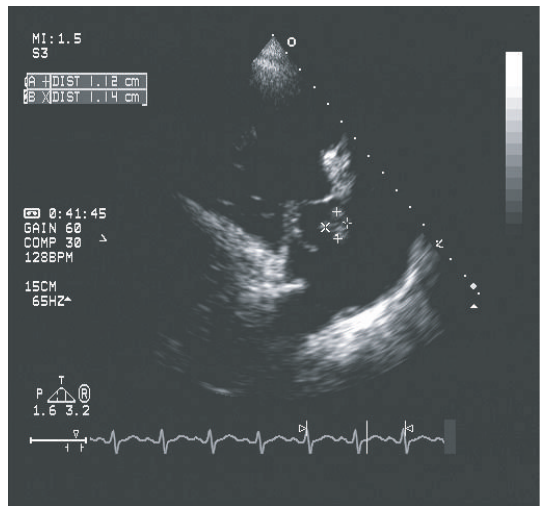
Figure 1: Tricuspid valve vegetation measuring 1 . 14cm × 1 . 12cm in this